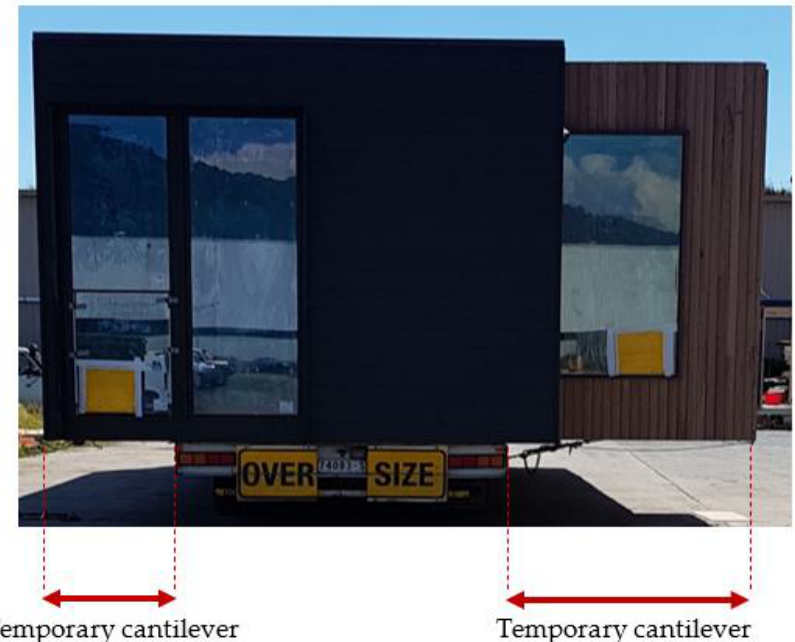
Figure 5. Temporary support conditions—An example of a situation where cantilevers which would not be there in the final state of a structure are imposed on a module during transportation.